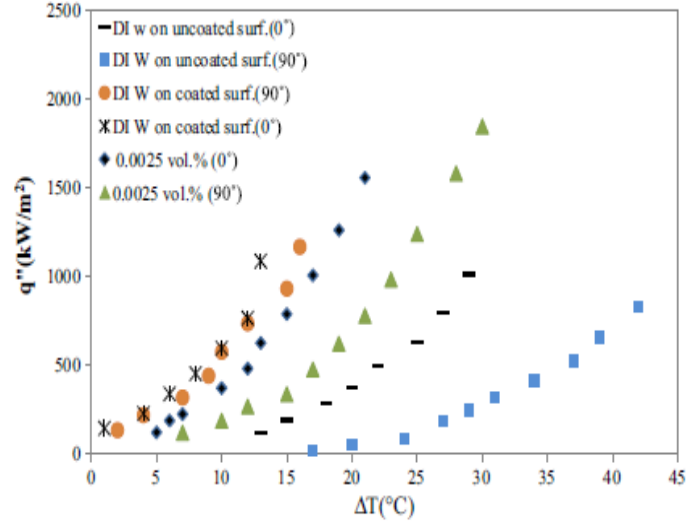
Figure 13. Boiling curves of deionized water on nanocoated and uncoated surfaces and comparing with 0.0025 vol.% nanofluid at various inclination angles of the heater [129].